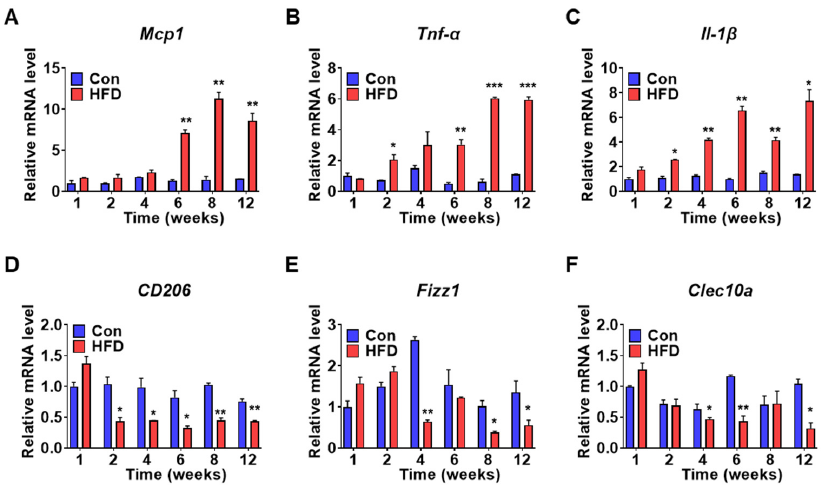
Figure 5. HFD promotes inflammatory gene expression in the liver: ( A – C ) mRNA expression levels for pro-inflammatory genes of liver from control and HFD-fed WT mice ( n = 5). qPCR was used for analyzing Mcp1, Tnf- α , and Il-1 β mRNA expression. ( D – F ) mRNA levels of anti-inflammatory genes, CD206, Fizz1, and Clec10a in the liver ( n = 5). * p < 0.05, ** p < 0.01, and *** p < 0.001 control vs. HFD-fed WT mice of the respective weeks. Mcp1: monocyte chemoattractant protein 1, Tnf- α : tumor necrosis factor-alpha, Il-1 β : interleukin-1 beta, CD206: mannose receptor c-type 1, Fizz1: inflammatory zone 1, Clec10a: c-type lectin domain containing 10, member A. 3.6. Characterization of Pre-DM Biomarkers in the Liver To identify pre-DM biomarkers, mRNA and protein levels of selected genes were measured in the liver samples of control and HFD-fed mice. mRNA expression of several genes was increased in the pre-DM stage; these genes were identified as novel pre-DM biomarkers. mRNA expression of Lgals1 and Fcgr2b was significantly upregulated in HFD-induced pre-DM mice after 6 and 8 weeks, respectively, compared with that in control mice at the respective weeks (Figure 6A,B). Similarly, mRNA expression of Vcam1 was significantly higher in HFD-induced pre-DM mice from the first week to the progression from pre-DM to T2DM stage compared with that in control mice at the respective weeks (Figure 6C). Similarly, mRNA expression of Igfbp5 and Gas6 was significantly upregulated in HFD-induced pre-DM mice in the first week and after 6 weeks compared with that in control mice at the respective weeks (Figure 6D,E). Protein levels of FCGR2b, LGALS1, VCAM1, IGFBP5, and GAS6 increased after 6 weeks in HFD- induced pre-DM mice (Figure 6F). Furthermore, mRNA expression of pre-DM marker genes was measured in the liver samples from ob/ob and db/db mice. In both ob/ob and db/db mice, mRNA expression of Lgals1, Vcam1, and Igfbp5 was significantly increased, whereas the mRNA expression of Fcgr2b was significantly decreased. mRNA expression of Gas6 was significantly increased in ob/ob mice, but was not altered in db/db mice (Supplementary Figure S1).